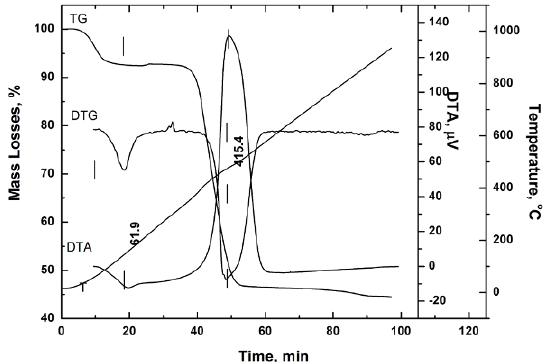
Figure 5. SEM micrograph of the sample TiO /AC material, 2 prepared at 680 o C. TiO particles with submicron (arrows 2 1, 2) and nanosized (arrows 3, 4) dimensions located on the surface of the activated carbon.